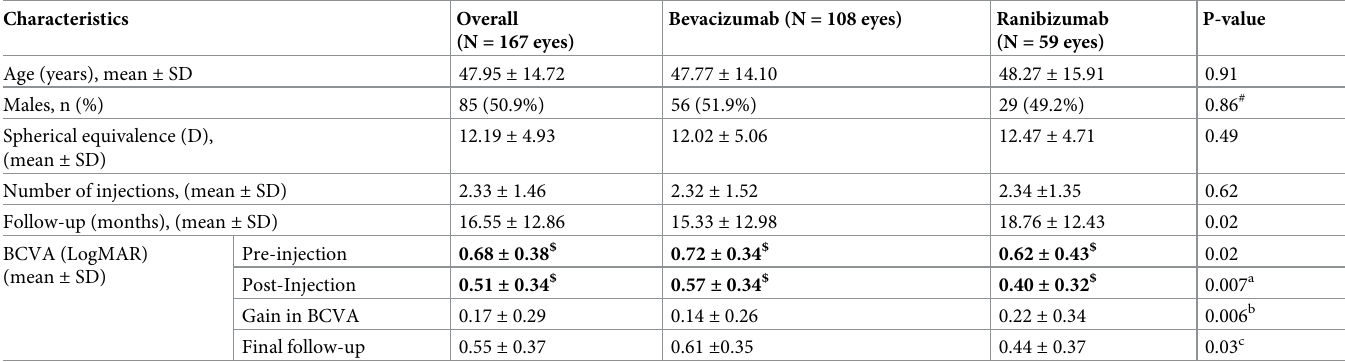
45.5% in the one injection, two injection and 3 or more injections groups, respectively (Fig 1A). At 18 months, the risk of recurrence was 12.1 (stable), 31.1 (two-fold increase) and 53.3% (marginal increase) in the one injection, two injection and 3 or more injections groups, respec- tively. The recurrence rate was similar in bevacizumab and ranibizumab group (Fig 1B). Response to re-treatment was evaluated in 44 eyes with recurrent m-CNV. Final BCVA in the recurrence group was not statistically different from that in non-recurrence group (0.53 ± 0.40 versus 0.55 ± 0.36 LogMAR; p = 0.755). A mean number of additional 1.90 ± 1.78 injection per eye was needed to treat recurrence. A secondary analysis was done to compare the efficacy and treatment burden between IVR and IVB groups and predictors of favourable visual outcomes. A sub-group analysis of the two anti-VEGF subgroups showed no difference in the mean age, gender, mean spherical equivalence and mean number of injections (Table 3). Mean